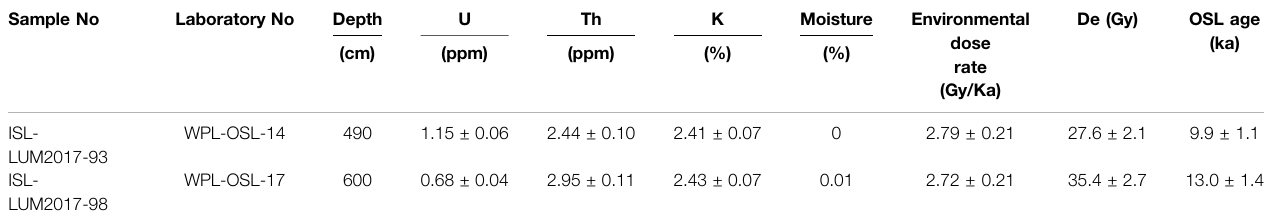
TABLE 3 | OSL dates for the WPL pro fi le.